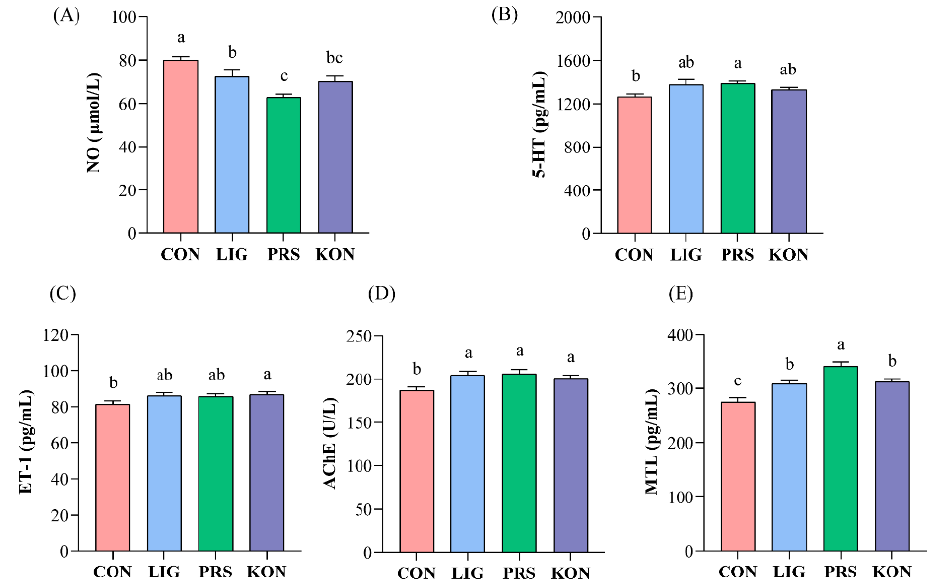
Figure 2. Effects of different fiber sources on the levels of 5-HT ( A ), NO ( B ), ET-1 ( C ), AChE ( D ), and MTL ( E ) in the serum of sows ( n = 7). CON, control; LIG, lignocellulose; PRS, resistant starch; KON, konjaku flour. 5-HT, 5-hydroxytryptamine; NO, nitrogen monoxide; ET-1, endothelin-1; AChE, acetylcholinesterase; MTL, motilin. Differences between the superscript letters for the peer data indicate that the difference is significant ( p < 0.05).